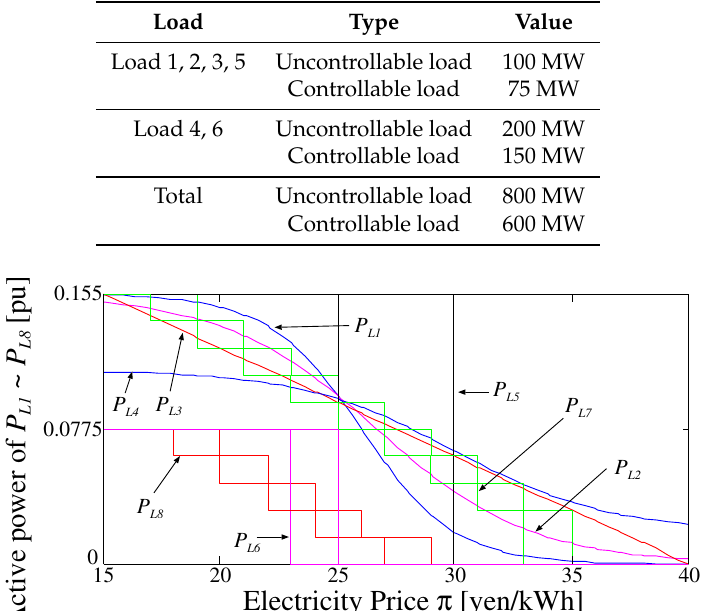
Table 4. Maximum consumption power of each load.